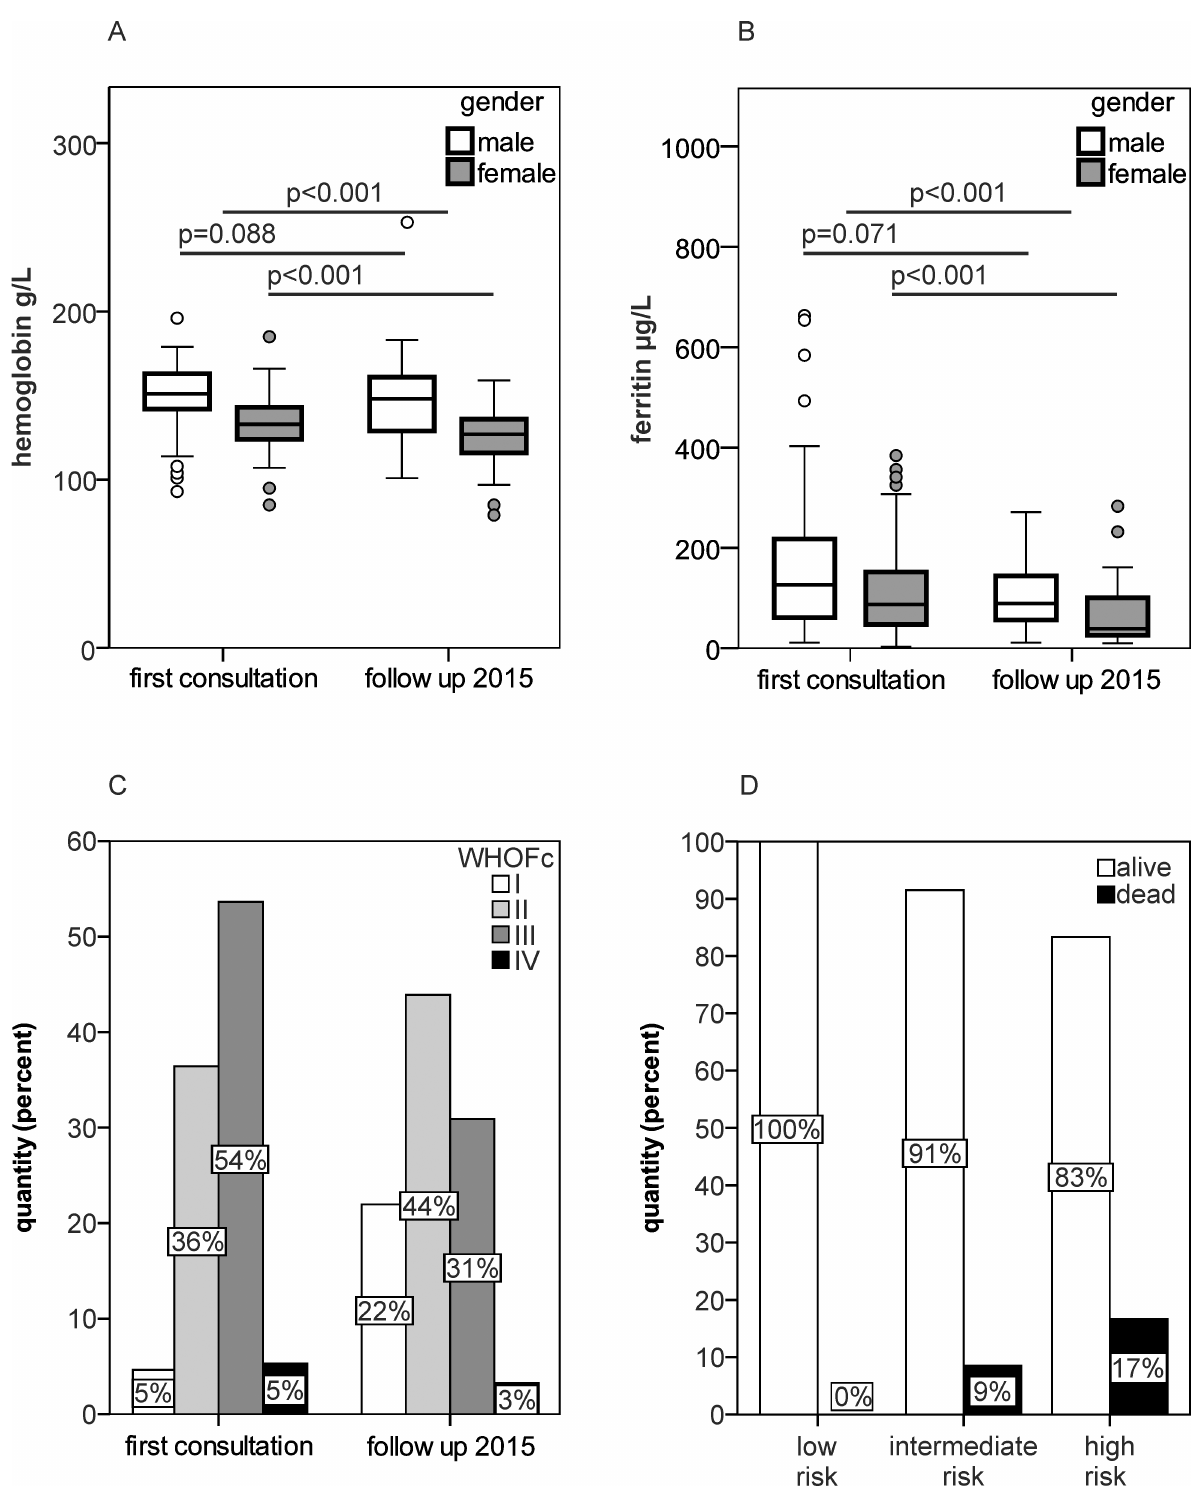
Fig 1. Patients’ hematological and clinical parameters at baseline and follow up. (A-B) Time course of hemoglobin (A) and serum ferritin (B) according to gender, (C) WHO functional class (WHOFc) in precapillary PH patients, (D) mortality during the observation period (2006–2016) according to risk assessment at first consultation. N at first consultation = 153 (female = 90/male = 63), N during follow up 2015 = 103 (female = 65/ male = 38). Statistical analysis for time-dependent changes was calculated for the 103 patients available at both visits.